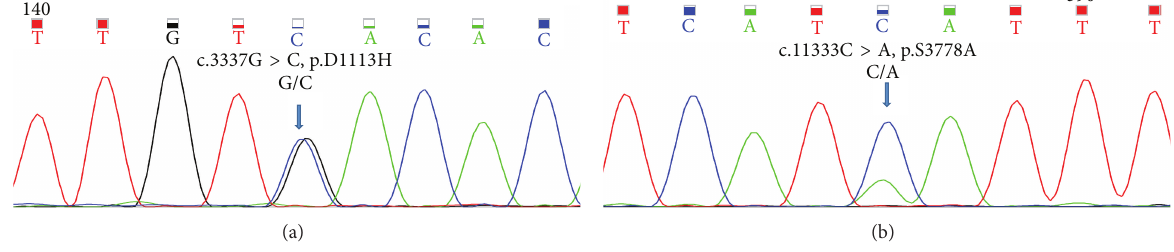
Figure 2: Sangers sequencing results of the APOB (NM 000384.2) variants identified by whole exome sequencing of the patient. (a) Showing the variant c.3337G > C in exon 22 and (b) showing the variant c.11333C > A in exon 26 of the APOB gene.